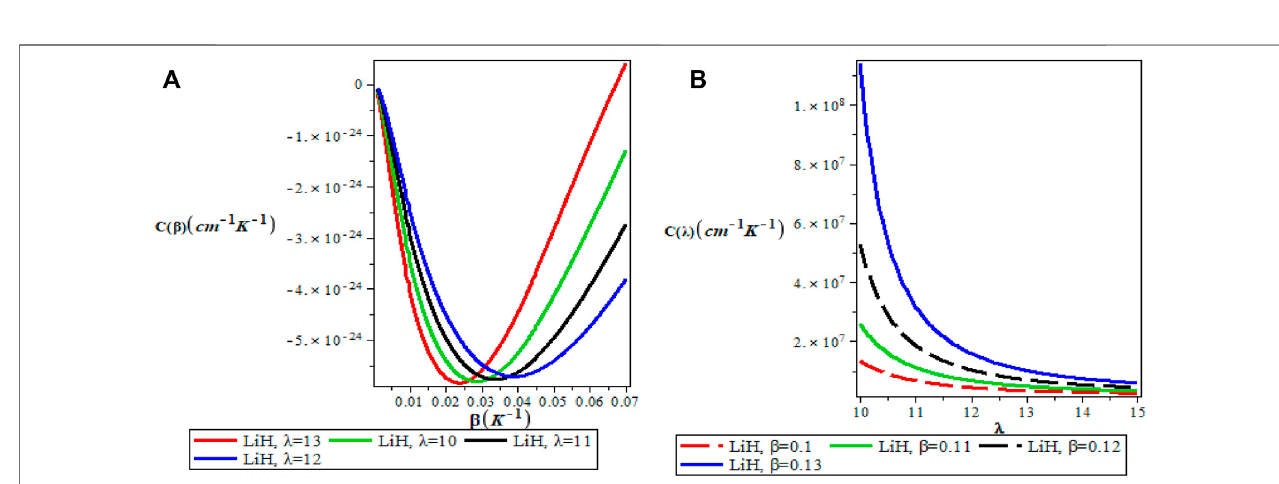
FIGURE 6 | (A) Variation of Vibrational Mean Energy With Respect to β (B) Variation of Vibrational Mean Energy With Respect to λ .